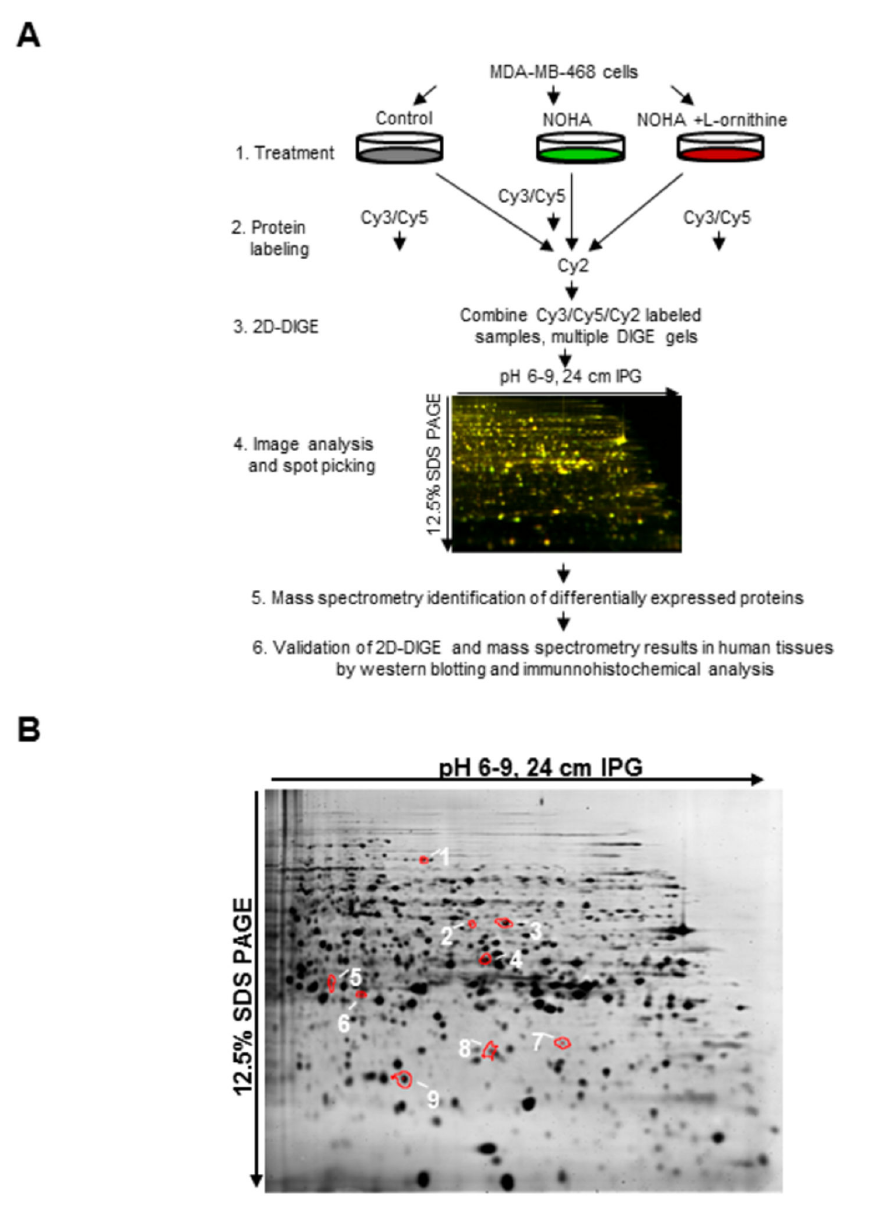
Figure 3. A , Schematic representation of 2D-DIGE/mass spectrometry analysis of MDA-MB-468 cells treated with NOHA and NOHA plus L-ornithine and validation of results in human tissues. B , 2D-DIGE analysis and identification of NOHA- induced mitochondrial proteins in MDA-MB-468 human breast cancer cells. Figure shows a representative Sypro Ruby-stained 2D- DIGE pH 6-9 gel image with NOHA-induced differentially expressed mitochondrial proteins. Samples labeled with Cy2, 3 and 5 dyes were cup-loaded onto a 24 cm pH 6-9 IPG strips. After isoelectric focusing, proteins were separated on 12.5% SDS PAGE. Gel images were acquired using the Typhoon scanner and analyzed by the DeCyder 2D software suite (v. 6.5). After proteins of interests were selected, picked up from gels and digested with trypsin, several differentially expressed mitochondrial proteins were identified by MALDI TOF/TOF mass spectrometry: 1 - adenylate kinase 2, 2 - ES1 protein homolog, 3 - mitochondrial 39S ribosomal proteins L28, 4 - putative mitochondrial carrier protein FLJ44862, 5 - acetyl-CoA acetyltransferase, 6 - mitochondrial 39S ribosomal proteins L39, 7 and 8 - two forms of mitochondrial serine hydroxymethyltransferase, 9 - mitochondrial aconitate hydratase. Three additional mitochondrial proteins were identified during the analysis of pH 4-7 DIGE gels: 28S ribosomal protein S22, cytochrome b- c1 complex subunit 1 mitochondrial precursor protein, and NADH-ubiquinone oxidoreductase 75 kDa subunit mitochondrial precursor protein (see Table 1). doi: 10.1371/journal.pone.0079242.g003 PLOS ONE |